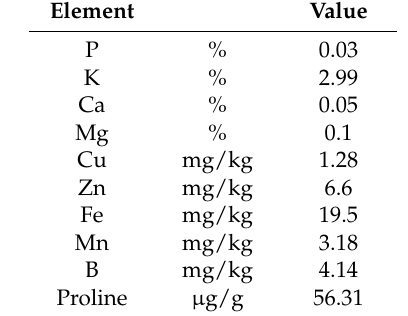
Table 4. Chemical composition of seaweed extract (%, mg/kg and µ g/g of dry weight). Element Value